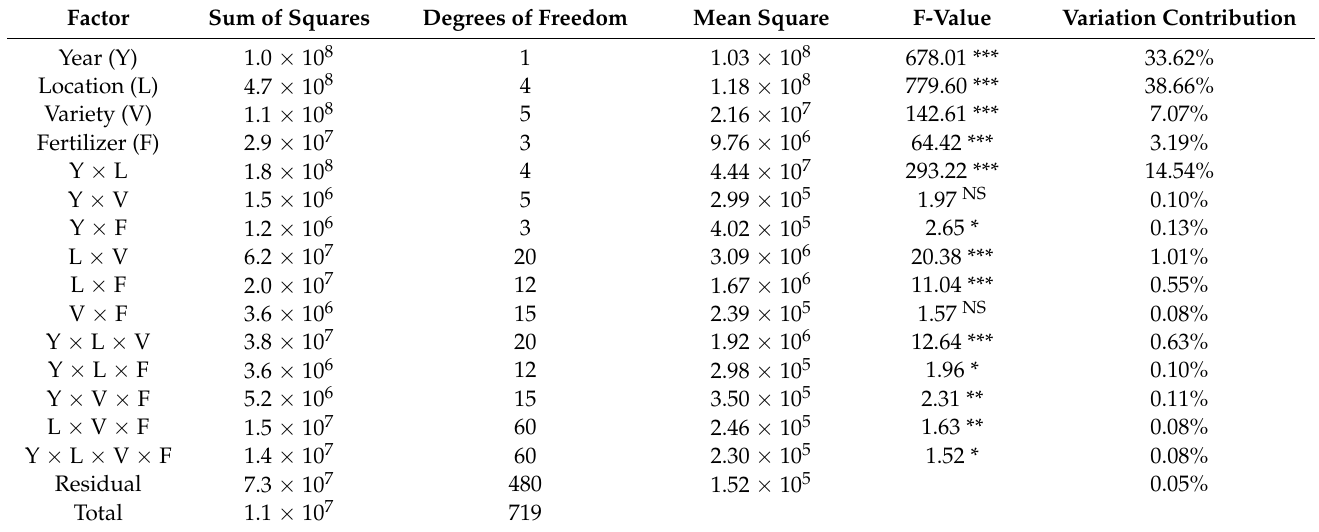
Table 5. ANOVA for yield traits studied along with its contribution toward total variation among six varieties of foxtail millet at five study sites with four fertilizer